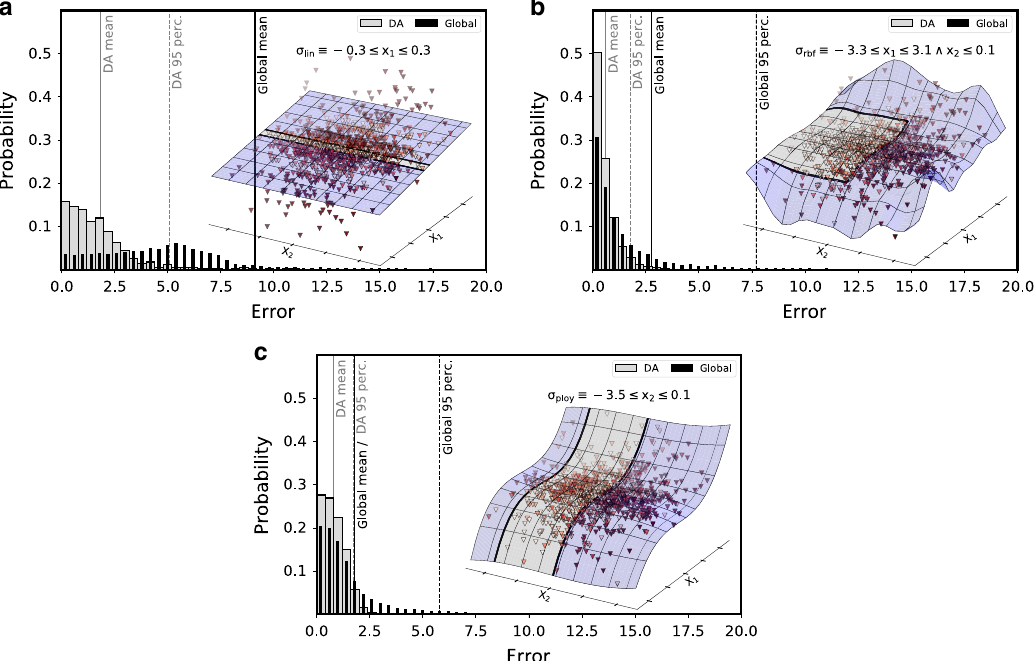
Fig. 1 Domains of applicability of three 2d-models of a noisy third-degree polynomial. Three different models, linear (top), radial basis function (rbf, center), and polynomial (poly, bottom), are shown approximating the same distribution of two independent features x 1 ~ N (0, 2) and x 2 ~ N (0, 2), and the (cid:2) x þ N ð 0 ; exp ð x = 2 ÞÞ , where N ( μ , ϵ 2 ) denotes a normal distribution with mean μ and standard deviation ϵ . Test points are plotted in target property y (cid:4) x 3 1 2 1 3d plots against the prediction surface of the models (color corresponds to absolute error) where the DA is highlighted in gray. The distributions of individual errors for the DA (gray) and globally (black) are shown in the 2d plots of each panel with the mean error (solid) and the 95th percentile (95 perc./dashed) marked by vertical lines. Note that the global error distribution of the linear model has a considerably long tail, which is capped in the